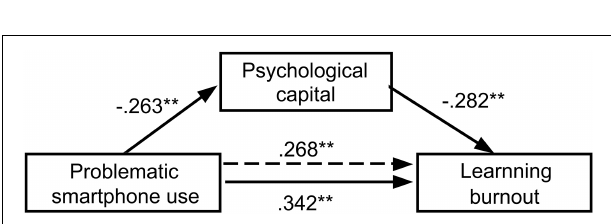
FIGURE 2 | Models of the mediating effect of psychological capital between problematic smartphone use and learning burnout in medical undergraduates; ∗ p < 0.05, ∗∗ p < 0.01.